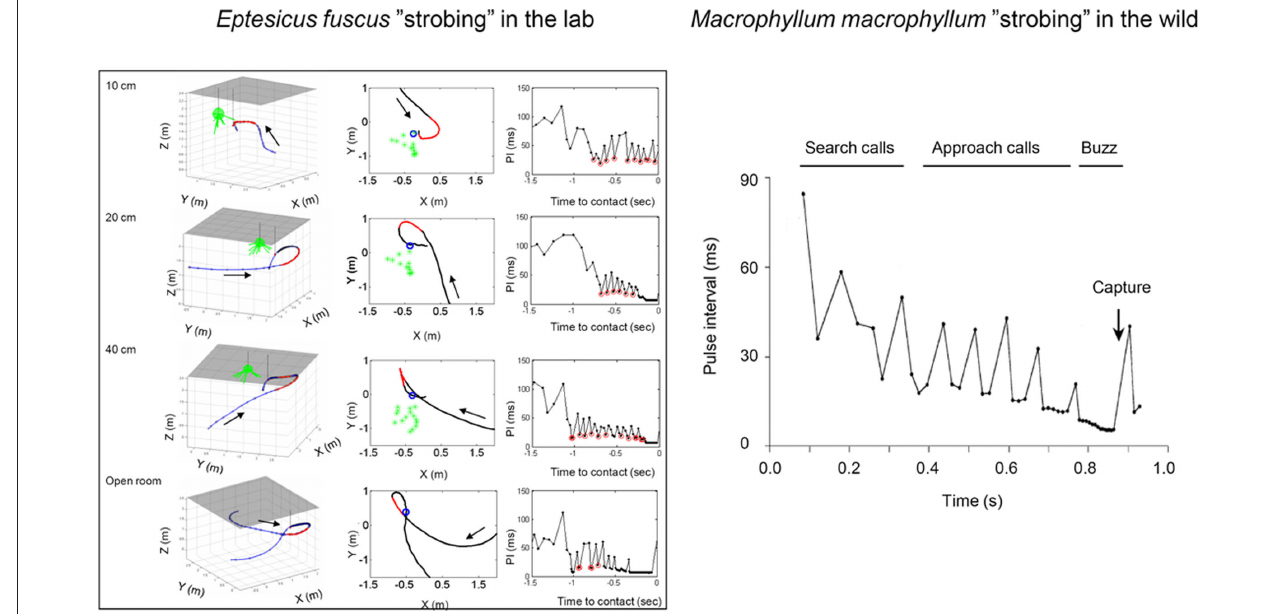
plot indicate the distance between the tethered insect and the vegetation, shown in green. Flight segments that contained “sonar strobe groups” are displayed in red. The pulse intervals for each of these four trials are plotted, and calls that fit the criterion for “sonar strobe groups” ( < 5% variation in PI) are circled in red. Adapted from Moss et al. (2006). Right, sonar strobing behavior taken from field recordings of M. macrophyllum . SC search calls, AC approach calls, TG terminal group, CM capture of mealworm. Adapted from Weinbeer and Kalko